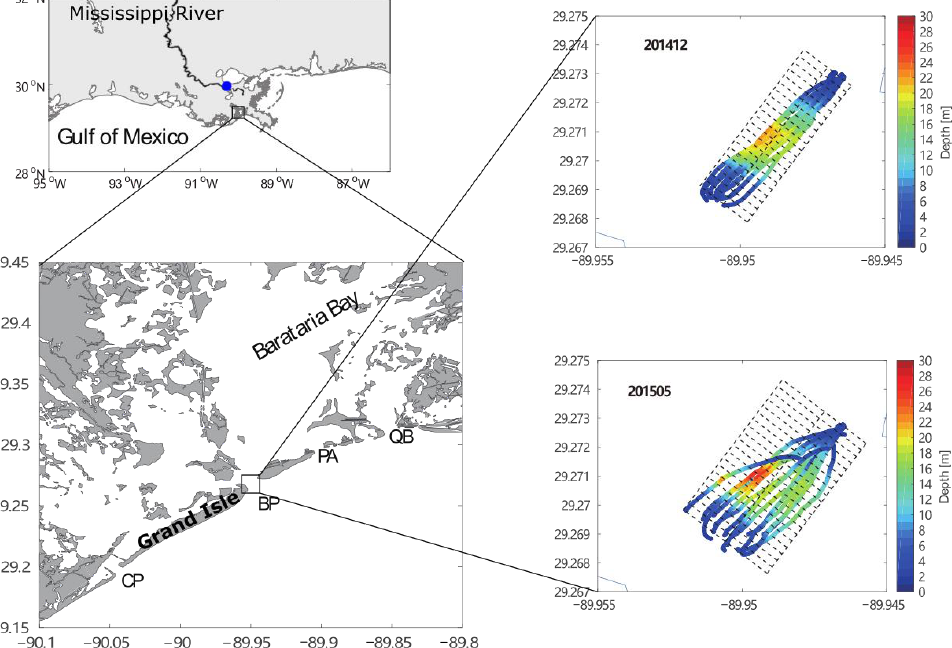
Figure 1. Map of study area and two section tracks from investigations in December 2014 and May 2015. The blue dot on the upper left panel marks the location of New Orleans Airport, where the wind field was observed. The colors in the right panels indicate the water depths measured along the track. The four inlets labeled in the lower left panel are the Caminada Pass (CP), Barataria Pass (BP), Pass Abel (PA), and Quatre Bayou Pass (QB) from southwest to northeast.